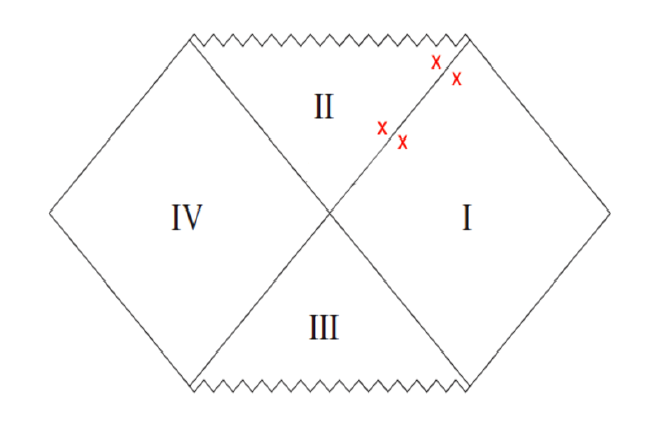
Figure 5 . Penrose diagram for a Schwarzschild black hole, with crosses indicating the near-horizon points at which a correlation function h (cid:30) ( x 1 ) (cid:30) ( x 2 ) (cid:30) ( x 3 ) (cid:30) ( x 4 ) i might be evaluated to compute cor- relations relevant to information-loss